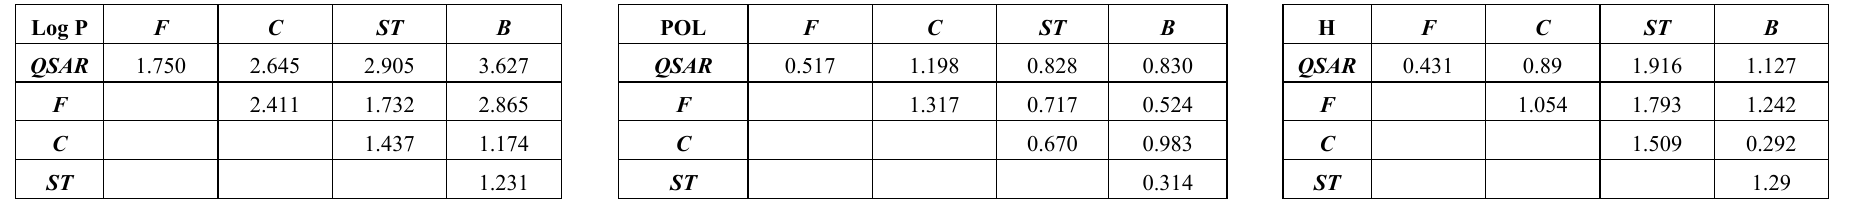
Table 7. Single-structure matrices of the Euclidean distances employing Equation (12).